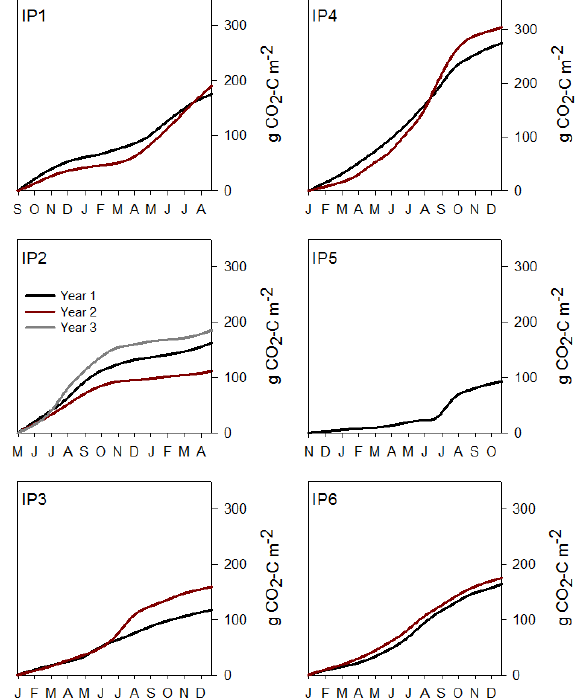
Figure 4. Annual cumulative ecosystem respiration ( R eco :gCO 2 - Cm − 2 ) at sites IP1–6. Positive values indicate CO 2 -C flux from the peatland to the atmosphere (source). Value at end of the curve indi- cates the total annual R eco value. Brown line indicates year 1, black line year 2 and grey line year 3 of the study at the individual sites. Note the differences in integration period between sites ( x